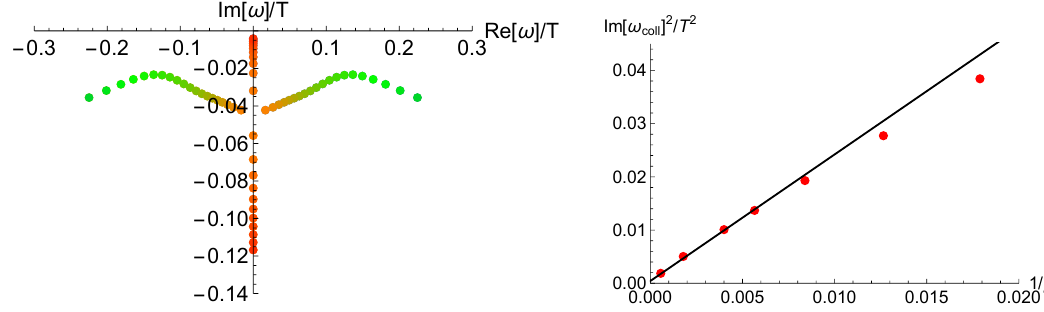
Figure 5 . Left : the lowest two QNMs at zero momentum for K = − 1 / 8 . We have fixed λ = √ 1 × 10 − 8 and T/ ρ ∈ [0.1, 0.4](green-red). Right : collision frequency Im ω coll as the function of β = h SSB i / h ESB i . We have fixed K = − 1 / 8 , λ ∈ [1 × 10 − 8 , 1 × 10 − 5 ] and α/ line indicates linear